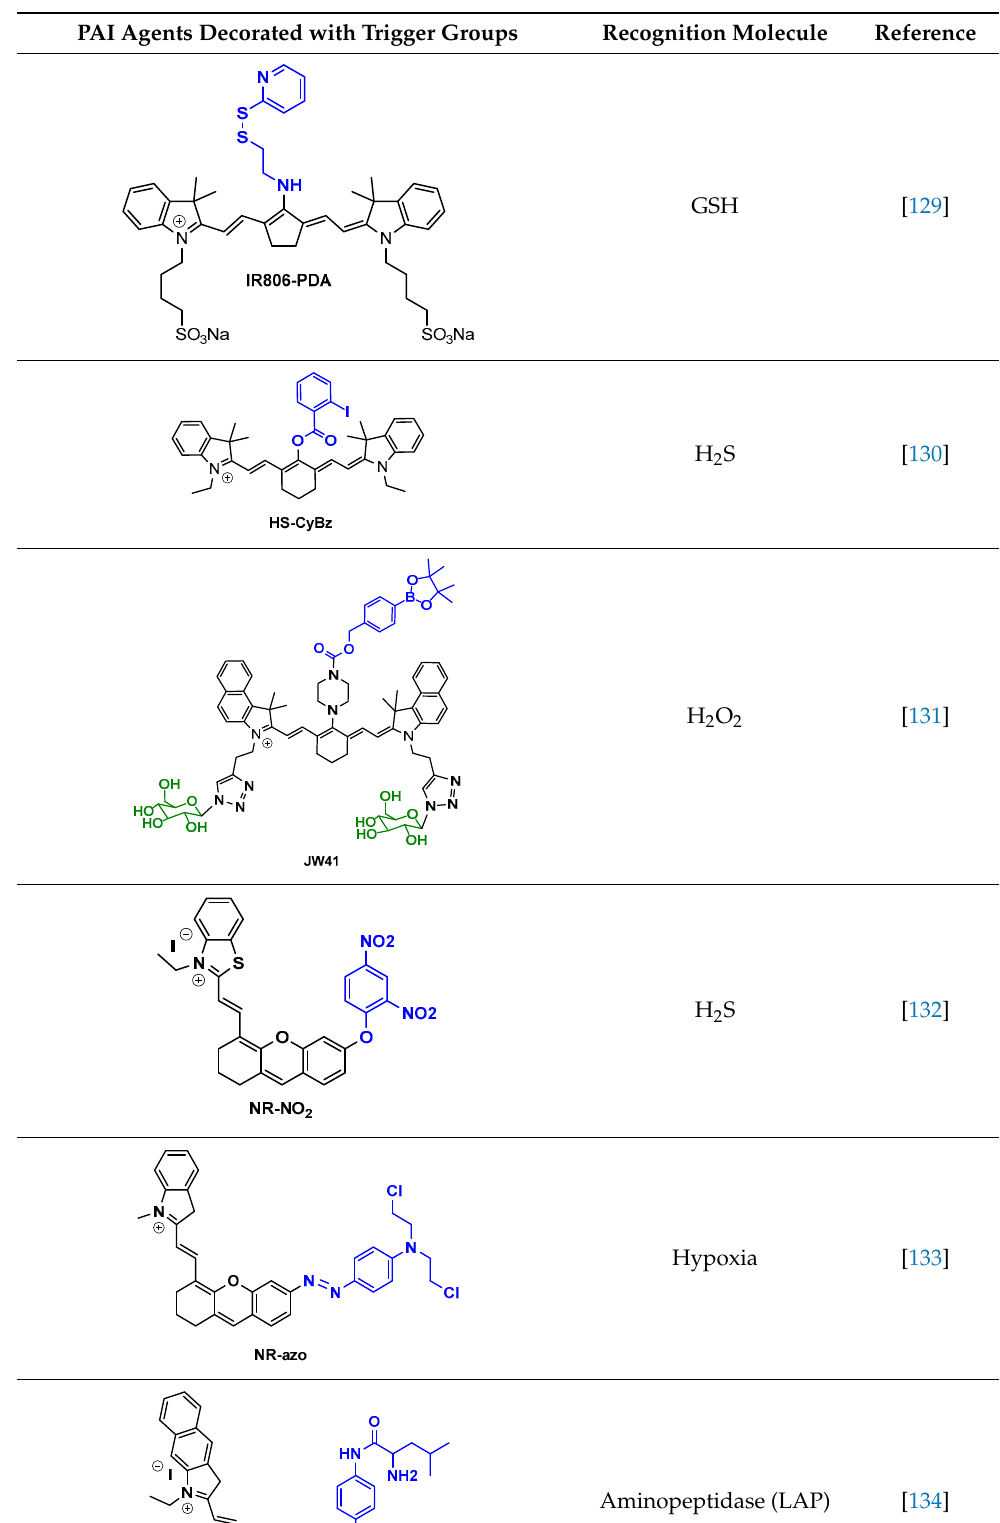
Table 3. Cyanine and semi ‐ cyanine conjugates used for photoacoustic imaging with different trigger groups. Trigger groups are colored in blue; target groups are colored in green.